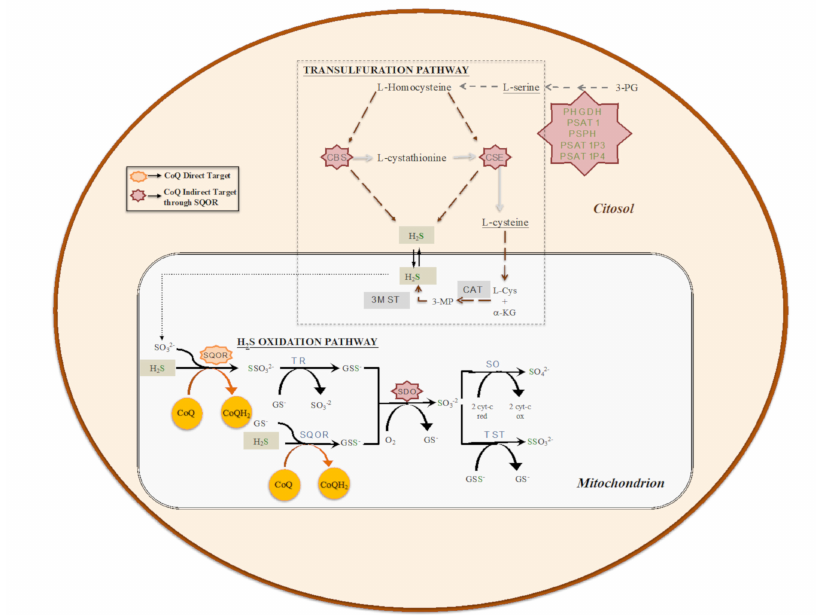
Figure 2. The biosynthetic (transsulfuration) and catabolic (oxidation) pathways of H 2 S. Transsulfu- ration pathway involves the enzymes cystathionine β -synthase (CBS), cystathionine γ -lyase (CSE) and pyridoxal-5 (cid:48) -phosphate (PLP)-independent 3-mercaptopyruvate sulfurtransferase (3MST). Mi- tochondrial H 2 S oxidation pathway involves the enzymes sulfide:quinone oxidoreductase (SQOR), sulfur dioxygenase (SDO; also known as ETHE1 or persulfide dioxygenase), sulfite oxidase (SO), thiosulfate sulfurtransferase or rhodanese (TST) and thiosulfate reductase